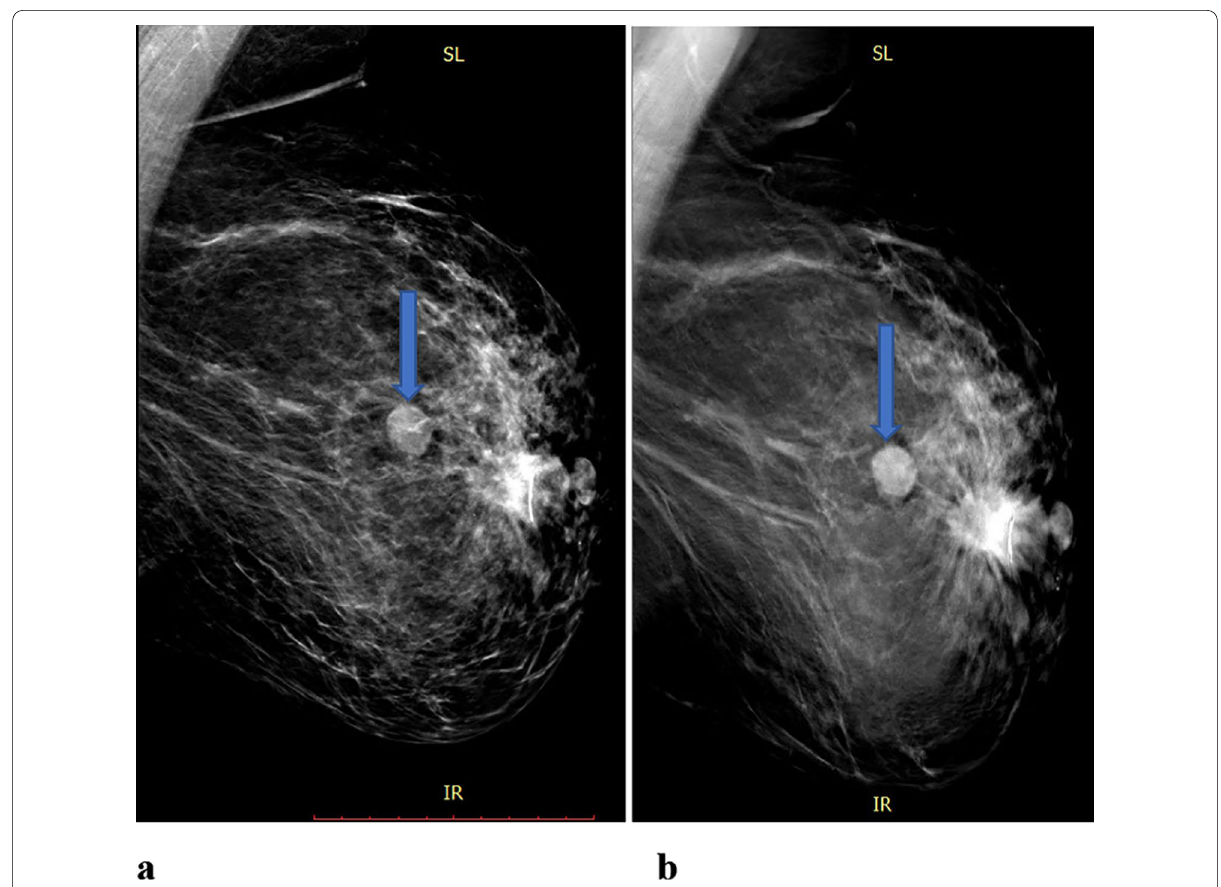
Fig. 6 A 36-year-old female patient with known invasive ductal carcinoma of left breast subjected to new adjuvant Chemotherapy came for follow-up, a MLO view of 2DDM of the left breast shows Scattered fibro-glandular densities (ACR b). b MLO view of DBT of left breast, both modalities show the index carcinoma at areolar and peri areola position with evidence of malignancy with localizing seen in it, BIRADS 6. Another mass is detected in retroareolar area which is dense rounded with partially well-defined margins by 2DDM and which is dense irregular with partially speculated margins by DBT. BIRADS 4, proved by histopathology to be invasive ductal carcinoma so the diagnosis changed to be multifocal invasive ductal carcinoma and the decision of treatment will be